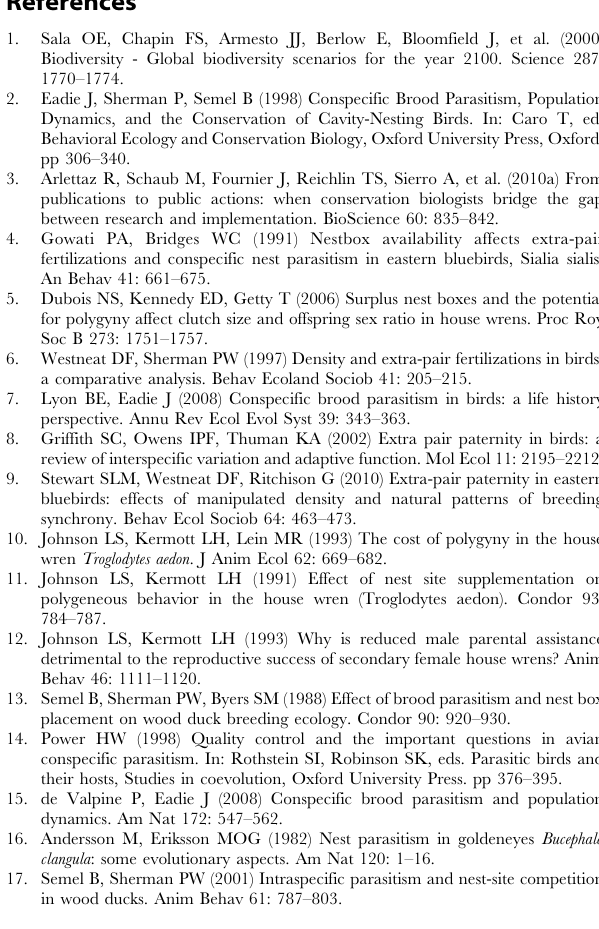
Table S1 Details of the results of the parentage assignment analysis with a 80% confidence